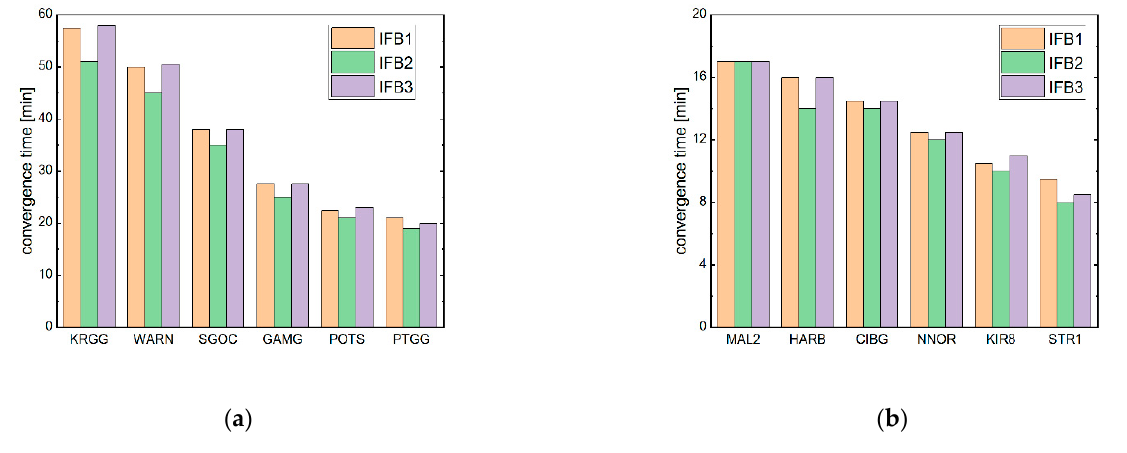
Figure 8. The convergence time of UC PPP for different schemes. Subfigure ( a ) is used to represent the stations whose convergence time is greater than 20 min, and subfigure ( b ) is for other stations. Table 7. The convergence time of UC PPP.